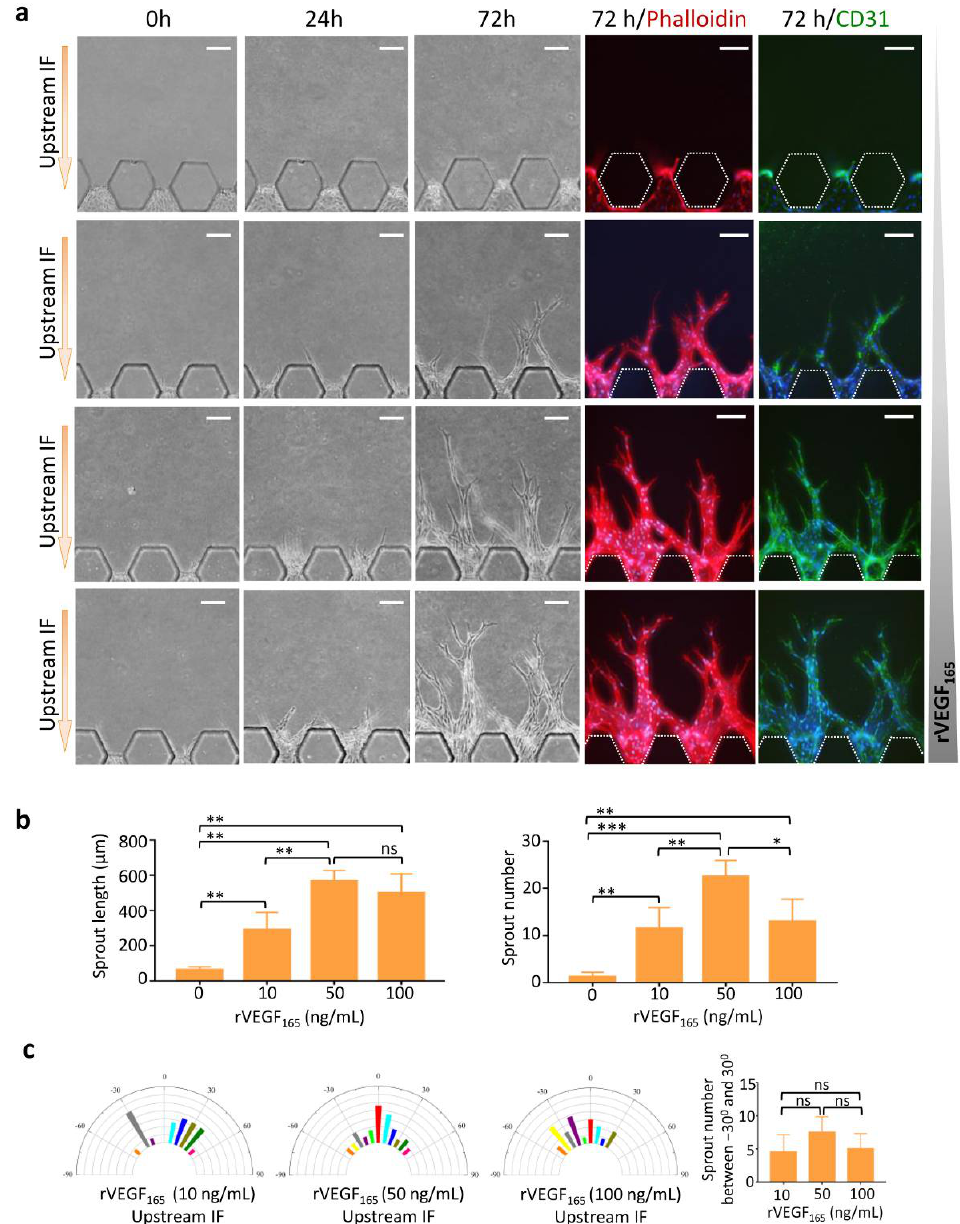
Figure 3. Optimal concentration of rVEGF 165 for angiogenesis. ( a ) Images of vascular sprouts induced by rVEGF 165 (0−100 ng/mL) in the presence of upstream IF. ( b ) Quantitative analyses of angiogenesis in terms of average sprout length and number. ( c ) Semicircular histograms showing distribution of orientation angle of the vascular sprouts stimulated by 10 ng/mL (left), 50 ng/mL (middle left), and 100 ng/mL (middle right) rVEGF 165 . Orientation of 0 represents the alignment of the sprout with the axis traversing channel C3. Quantitative analyses of sprout orientation (right). Scale bar = 100 μm. * p < 0.05, ** p < 0.01, *** p < 0.001.